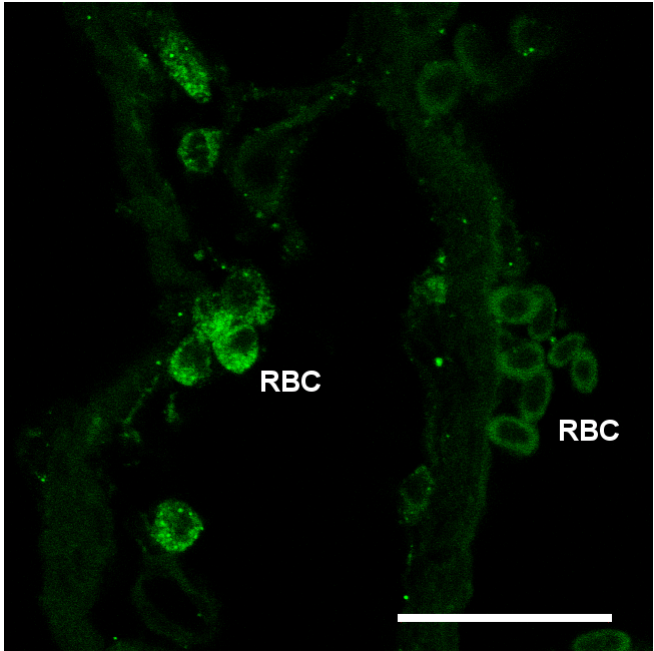
Figure 7. Confocal image of red blood cells (RBC) showing immunoreactivity against medaka AQP1 (green). Scale bar = 20 µ m.